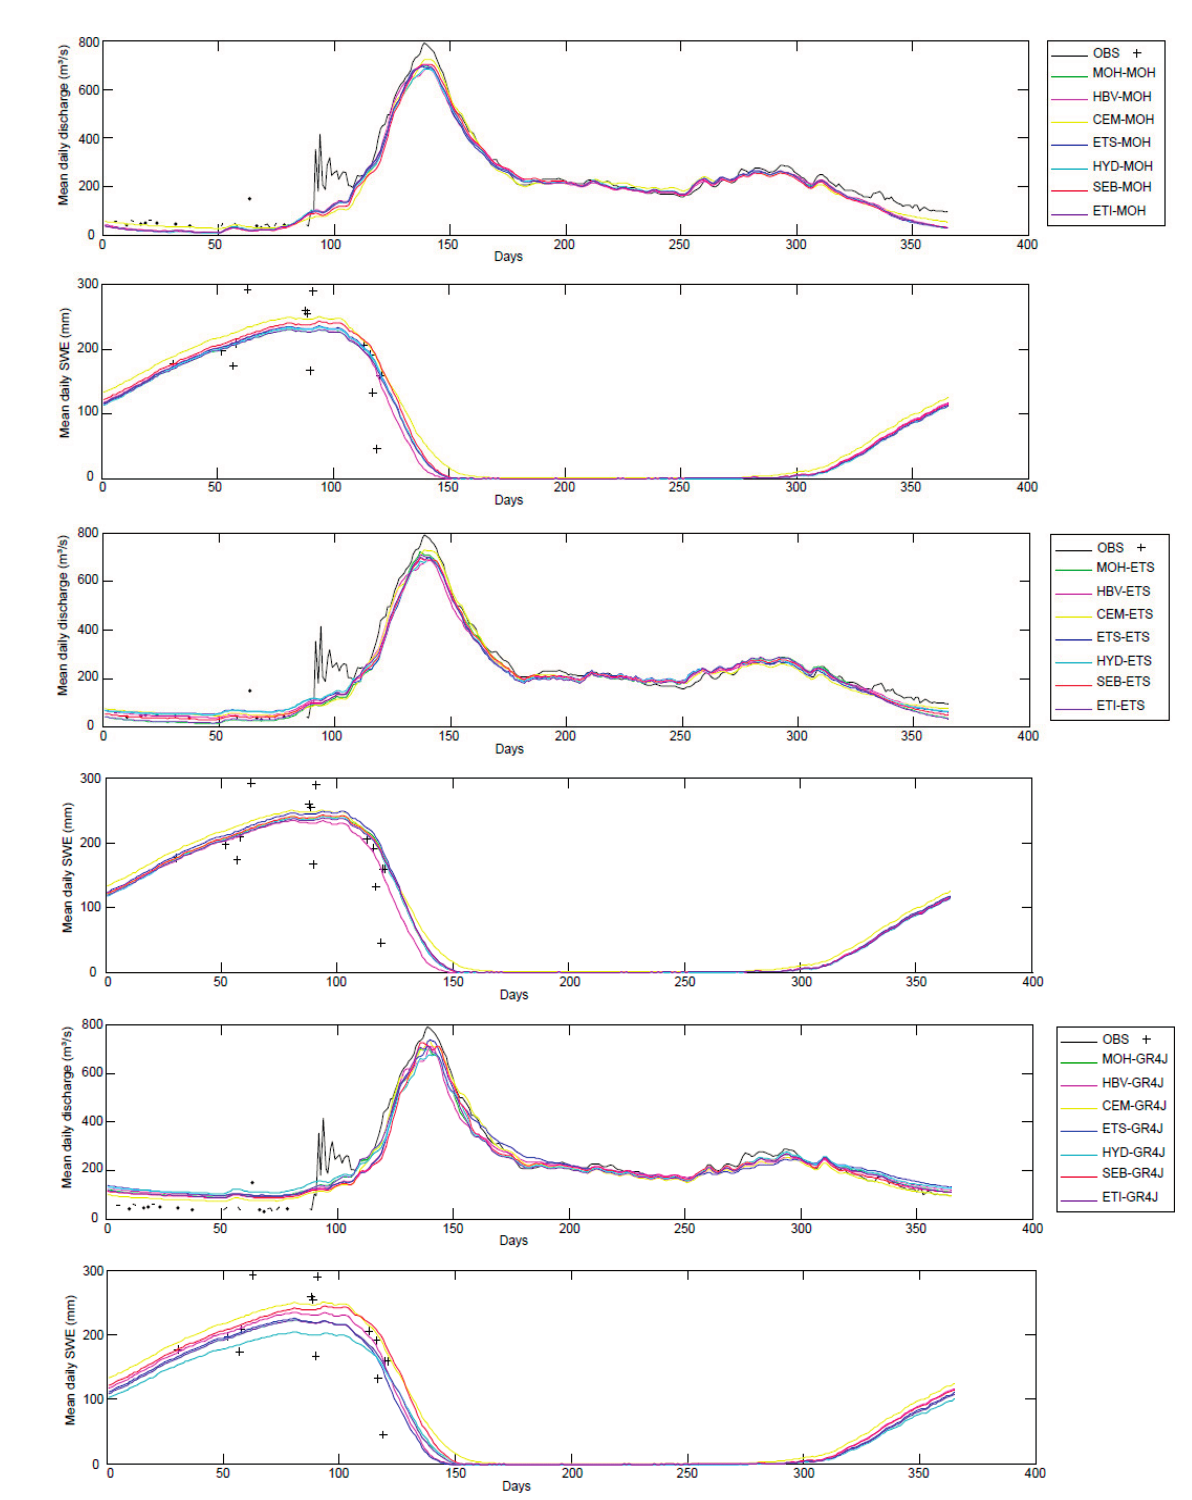
Figure 8. Mean annual hydrographs of observed (OBS), simulated discharges and SWEs using the 21 SM-HM combinations over the validation period (odd years over